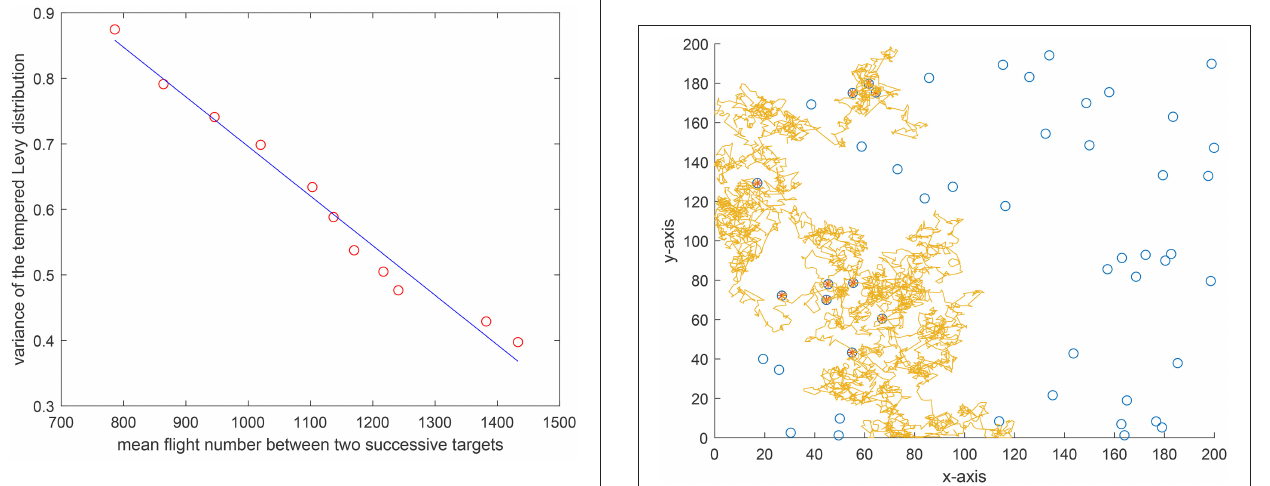
FIGURE 6 | The relation between the mean flight number and the variance of the tempered Lévy distribution.